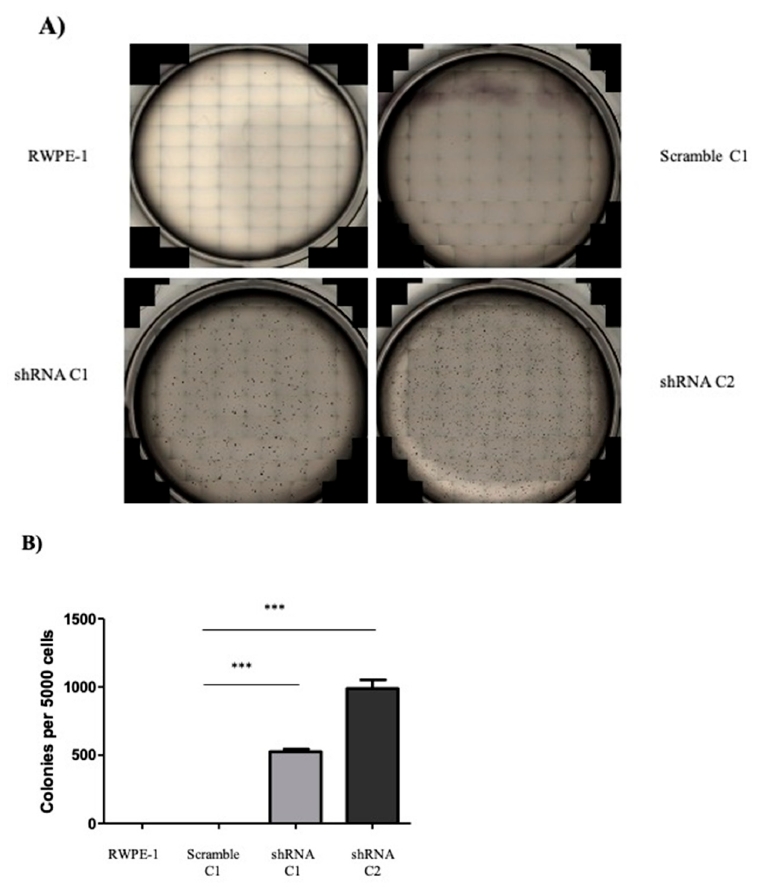
Figure 3. Reduction of SELENOF in RWPE-1 cells results in anchorage-independent growth. ( A ) Representative images of cells cultured in soft agar used to quantify the number of colonies formed. RWPE-1 and RWPE-1 scramble C1 did not form any colonies. ( B ) Quantification of the average number of colonies formed per 5000 cells plated. Data are represented in mean ± SEM, n = 3, and a two-tailed paired t -test was used to determine statistical differences *** p < 0.001.